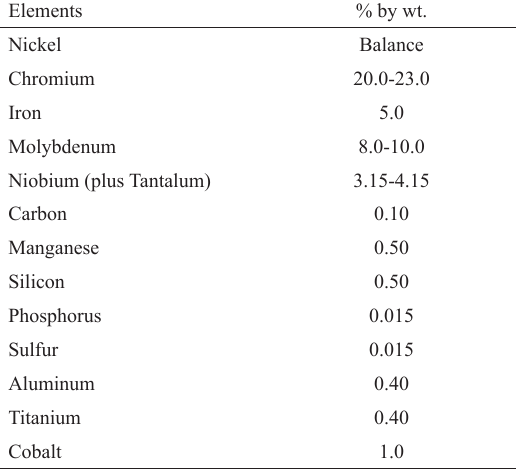
Table 2: Chemical composition of Almandine Garnet (Fe Elements % by wt.